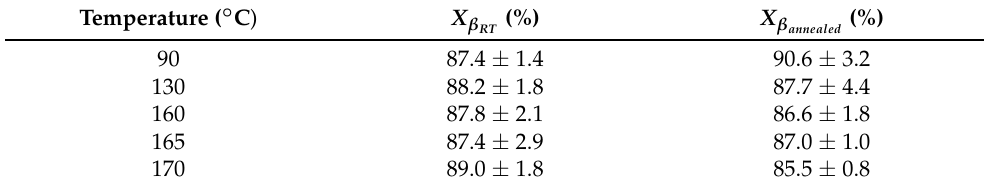
Table 3. Share of the crystalline β -Phase of the total crystallinity in the film (n =